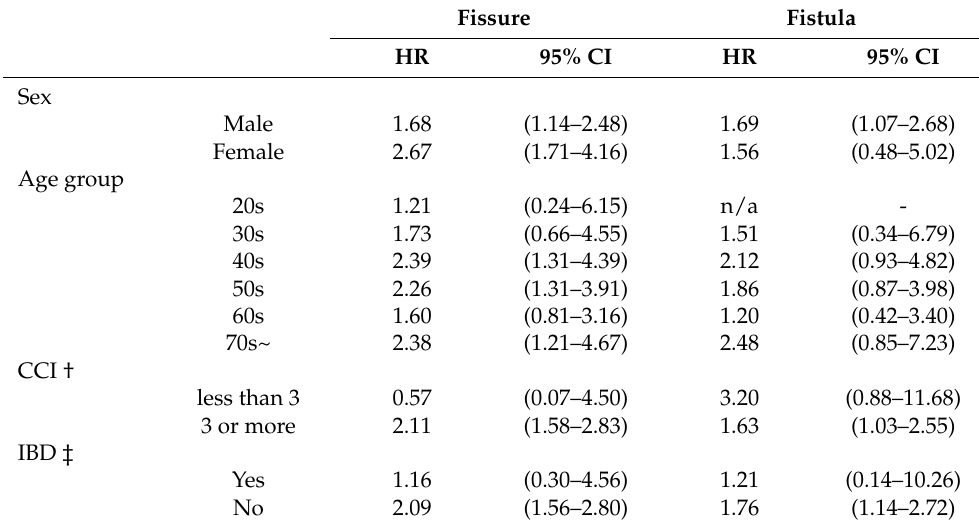
Table 4. Subgroup analyses on anorectal cancer by anal fissure and